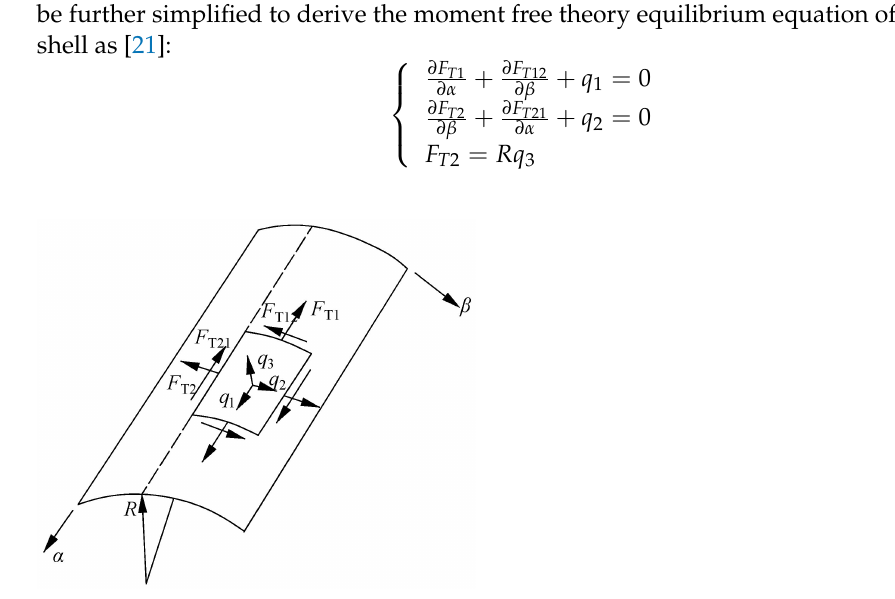
Figure 3. Cylindrical shell mechanical model.